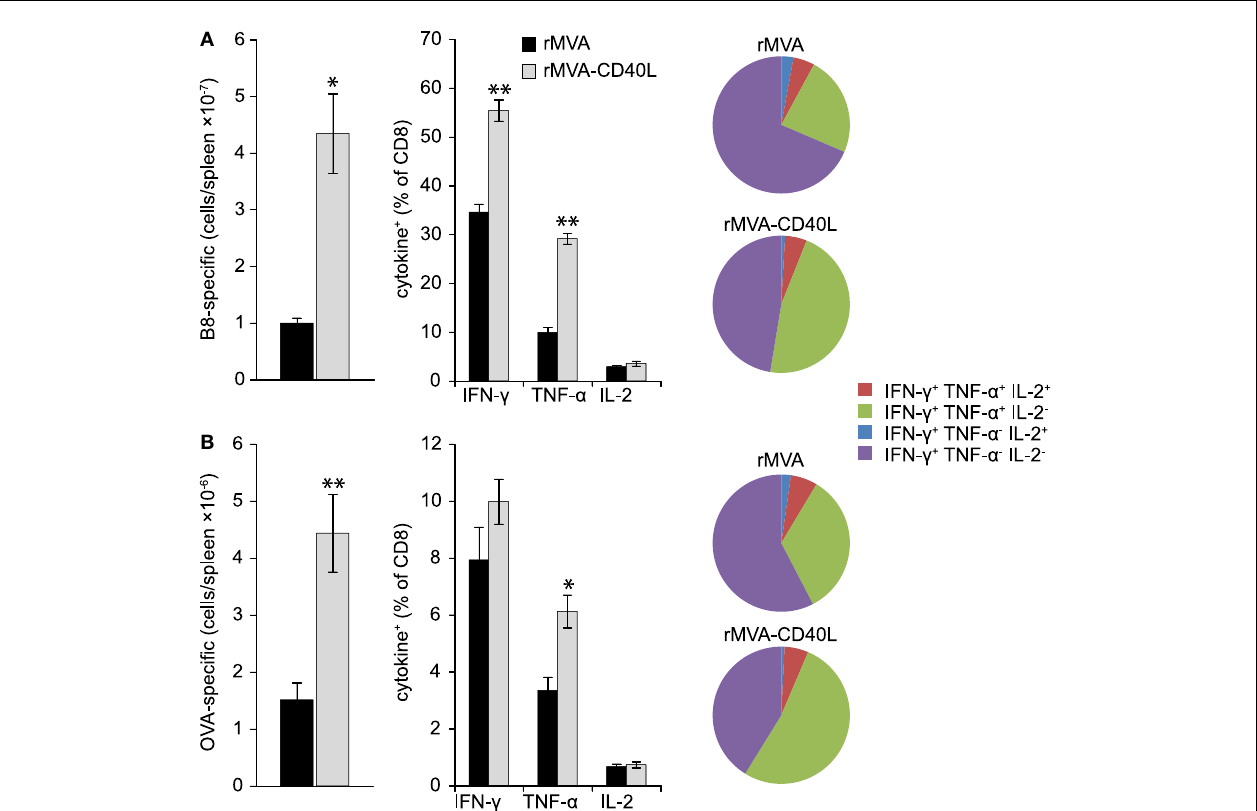
charts denote the fraction of IFN- γ + cells expressing IFN- γ alone (violet), IFN- γ andTNF- α (green), IFN- γ and IL-2 (blue), and IFN- γ ,TNF- α , and IL-2 (red). Note the increased percentage of IFN- γ /TNF- α double producer cells in rMVA-CD40L immunized mice (green area).Thus, in comparison to rMVA rMVA-CD40L immunization leads to functionally improved primary effector CD8T cells. Data are representative of five mice per group and two independent